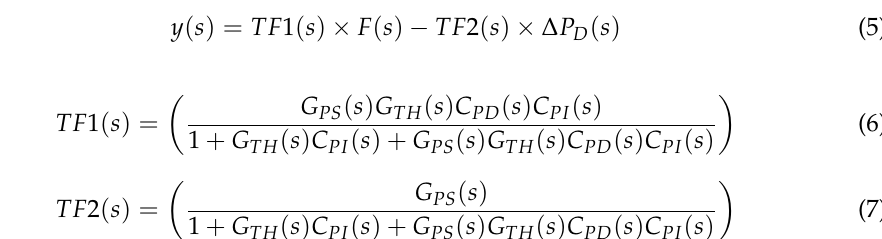
Figure 2. Proposed cascaded PD-PI controller. ( a ) Detailed cascaded PD-PI controller. ( b ) Cascaded PD-PI controller integration with the non-reheat thermal turbine generators and power system.